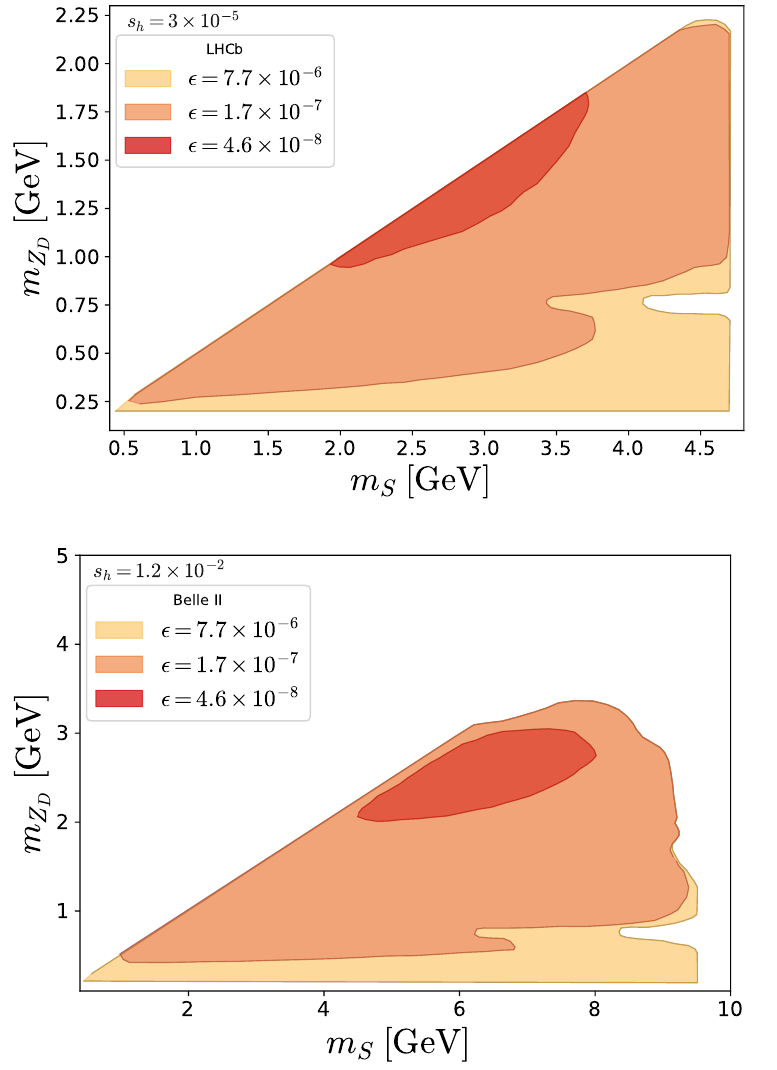
Figure 8 . Regions on the m S × m Z parameter space for the LHCb (upper panel) and Belle II D (lower panel) searches that satisfy N evts ≥ 3 . The colors denote different choices for the kinetic mixing value, as indicated in the labels. The sine of the mixing angle was fixed to s h = 3 × 10 − 5 ( s h = 1 . 2 × 10 − 2 ) in the upper (lower)